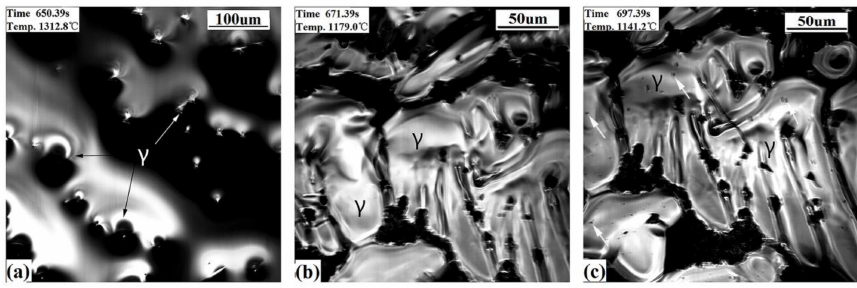
Figure 6. CSLM results of the high carbon steel (S3) at a cooling rate of 20 ◦ C/s. ( a ) γ growth; ( b ) γ phases; ( c ) precipitates emerging.